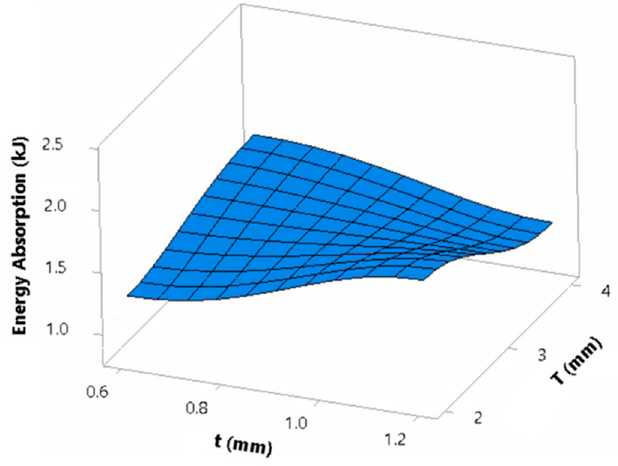
Figure 19. Influence of geometrical parameters on Energy Absorption.